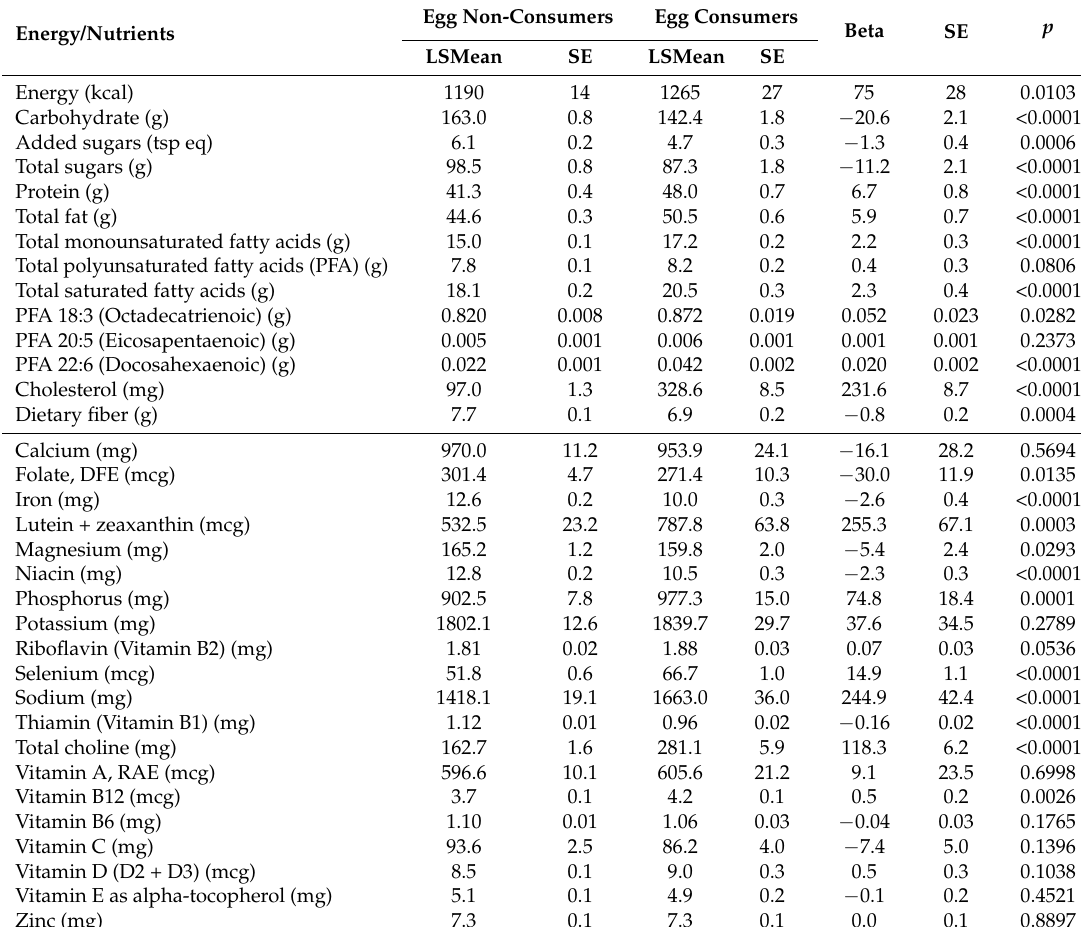
Table 2. Adjusted daily energy and nutrient intakes in egg consumers vs. egg non-consumers